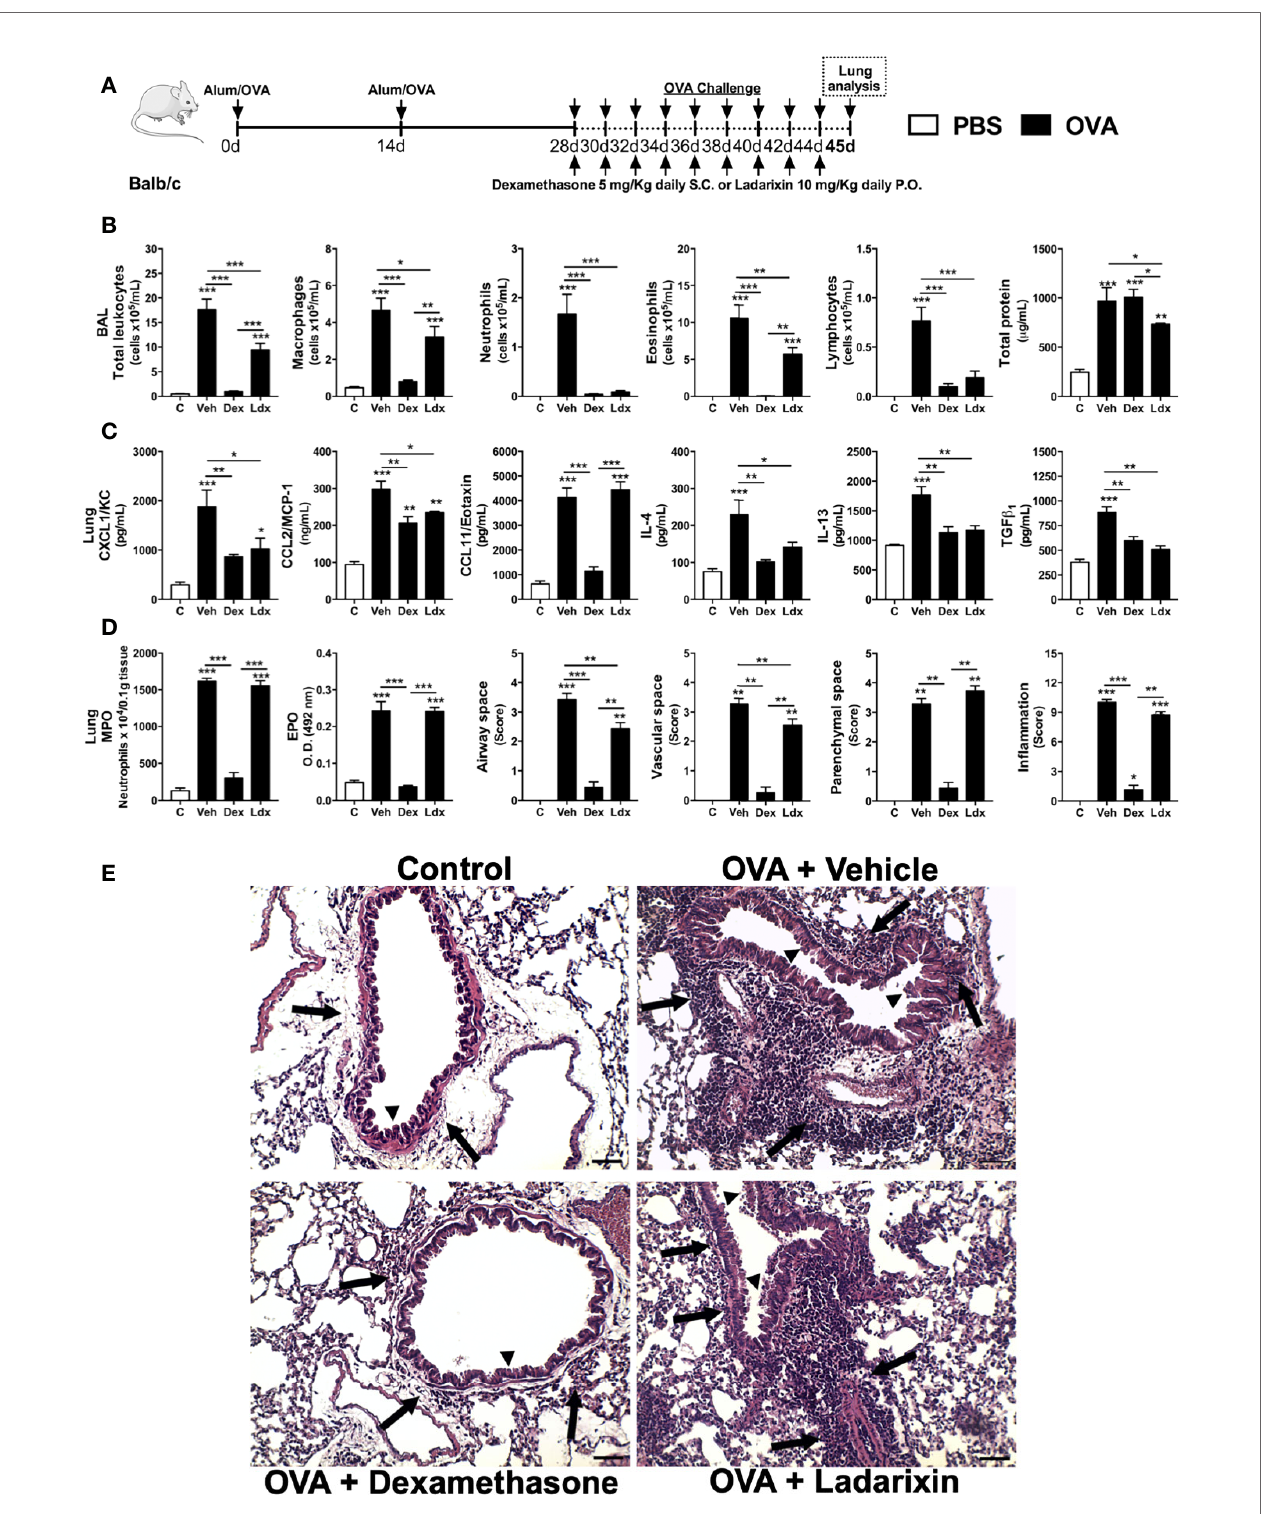
FIGURE 5 | Ladarixin reduces Th2 allergic airway and lung in fl ammation in chronic asthma model. In fl ammatory parameters were evaluated after 8 OVA challenges given every other day. (A) Schematic representation of the experimental design. (B) Assessment of leukocyte in fl ux and blood leakage into airways. (C) Chemokine and cytokine levels in lung parenchyma. (D) MPO and EPO activity quanti fi cation and pulmonary in fl ammation score. (E) Histological sections of lung (H&E dye). Arrows indicates peribronchial in fl ammation. Arrows head indicates mucus production. n = 8 for each group, * for P < 0.05; ** for P < 0.01 and *** for p <